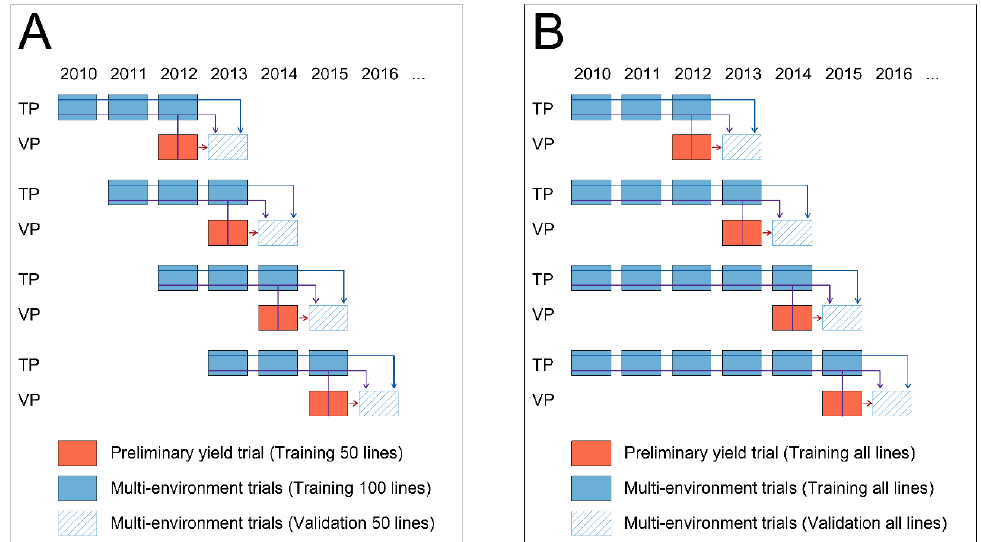
Figure 1. Schematic representation of the tested prediction scenarios with 3-year training population of lines tested in multi-environment trials ( A ) as well as cumulative training population coming from all years preceding a validation year ( B ). A total of 100 lines from each year were randomly sampled in a training population and 50 lines in a validation population in the first scenario, while in the second scenario all available lines were sampled in the training population and the prediction models were validation with the entire set of lines that was in common between the respective preliminary yield trials and subsequent year of multi-environment trials. Prediction models were either fitted without pre-existing information of the selection candidates in the validation population (blue arrows) or exploiting such information in common models (purple arrows) and compared with phenotypic selection based on observations from preliminary yield trials (red arrows).